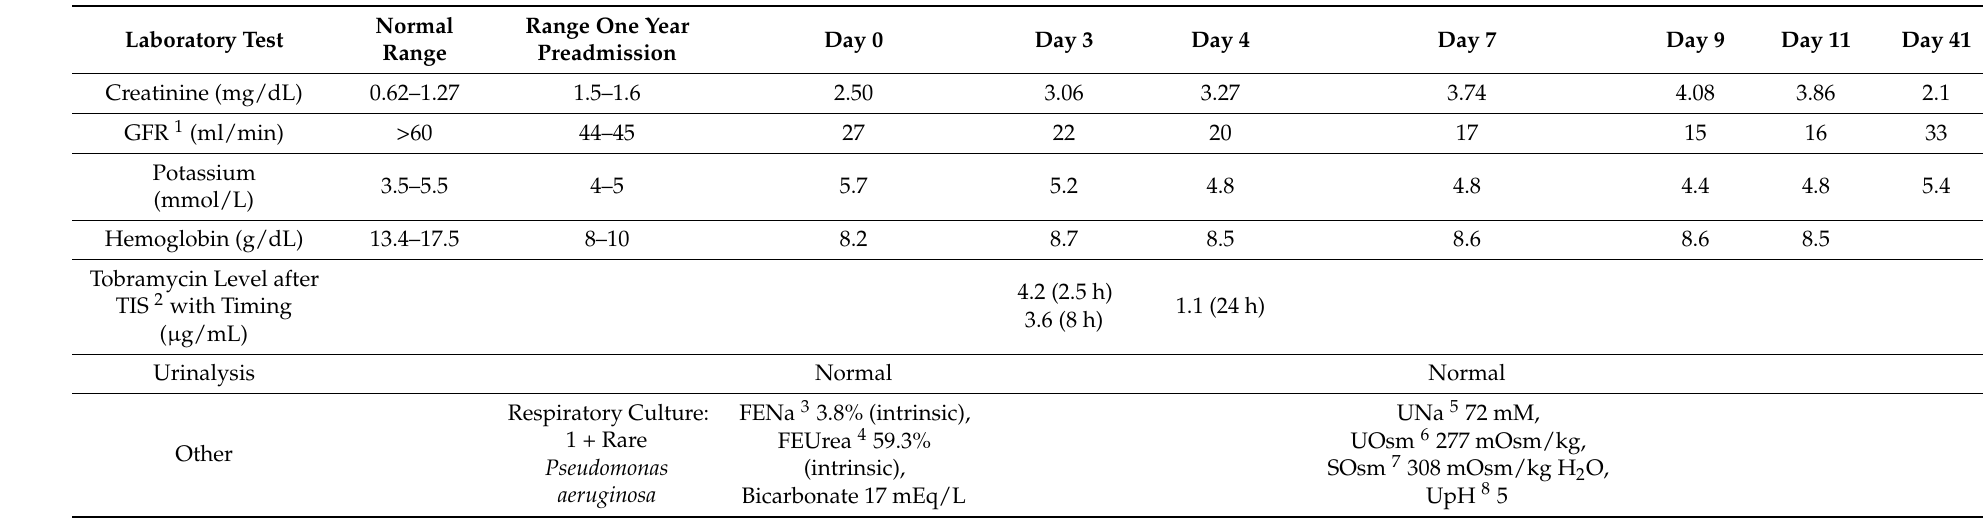
Table 1. Laboratory Values. The table shows pertinent laboratory value trends one-year preadmission, during hospitalization (day 0 to day 9), at discharge (day 11), and after follow-up (day 41) for our